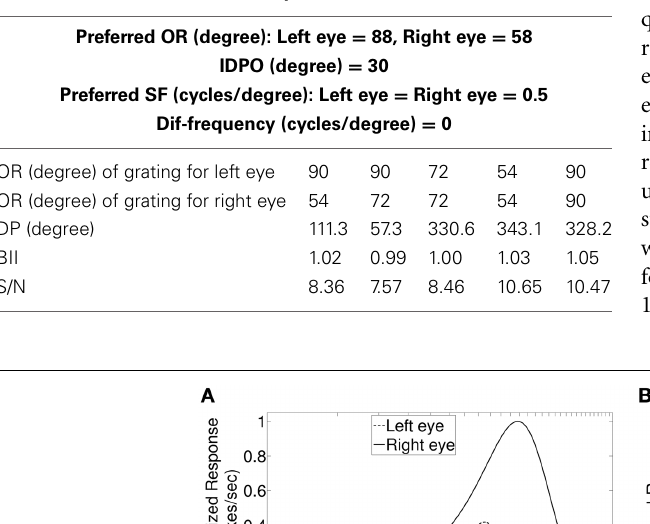
Table 3 | DP, BII, and S/N for a modeled cortical cell having unmatched OR and matched SF preference.